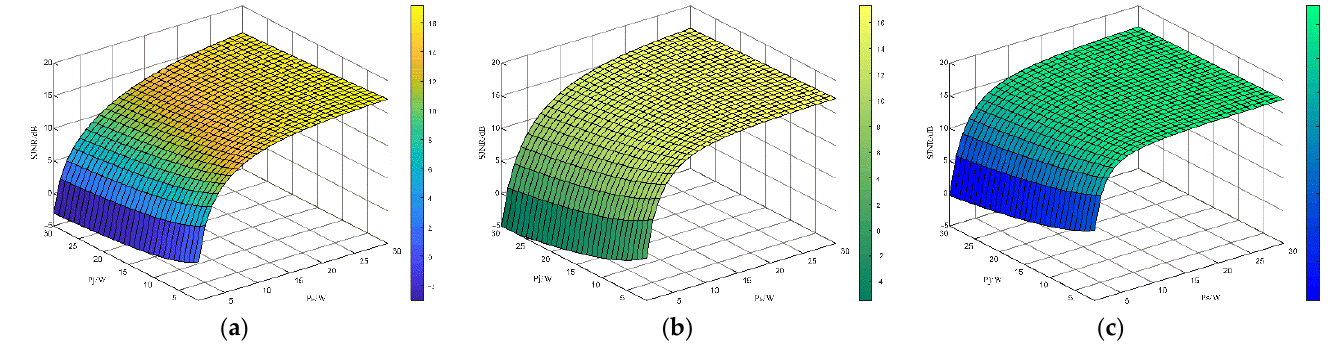
Figure 13. SJNR of the three signals under the conditions of jamming power and radar power variation. ( a ) Variation in LFM signal SJNR; ( b ) SJNR change graph of the anti-jamming signal generated based on strategy iteration method; ( c ) variation diagram of optimal anti-jamming signal SJNR generated based on D3QN algorithm.